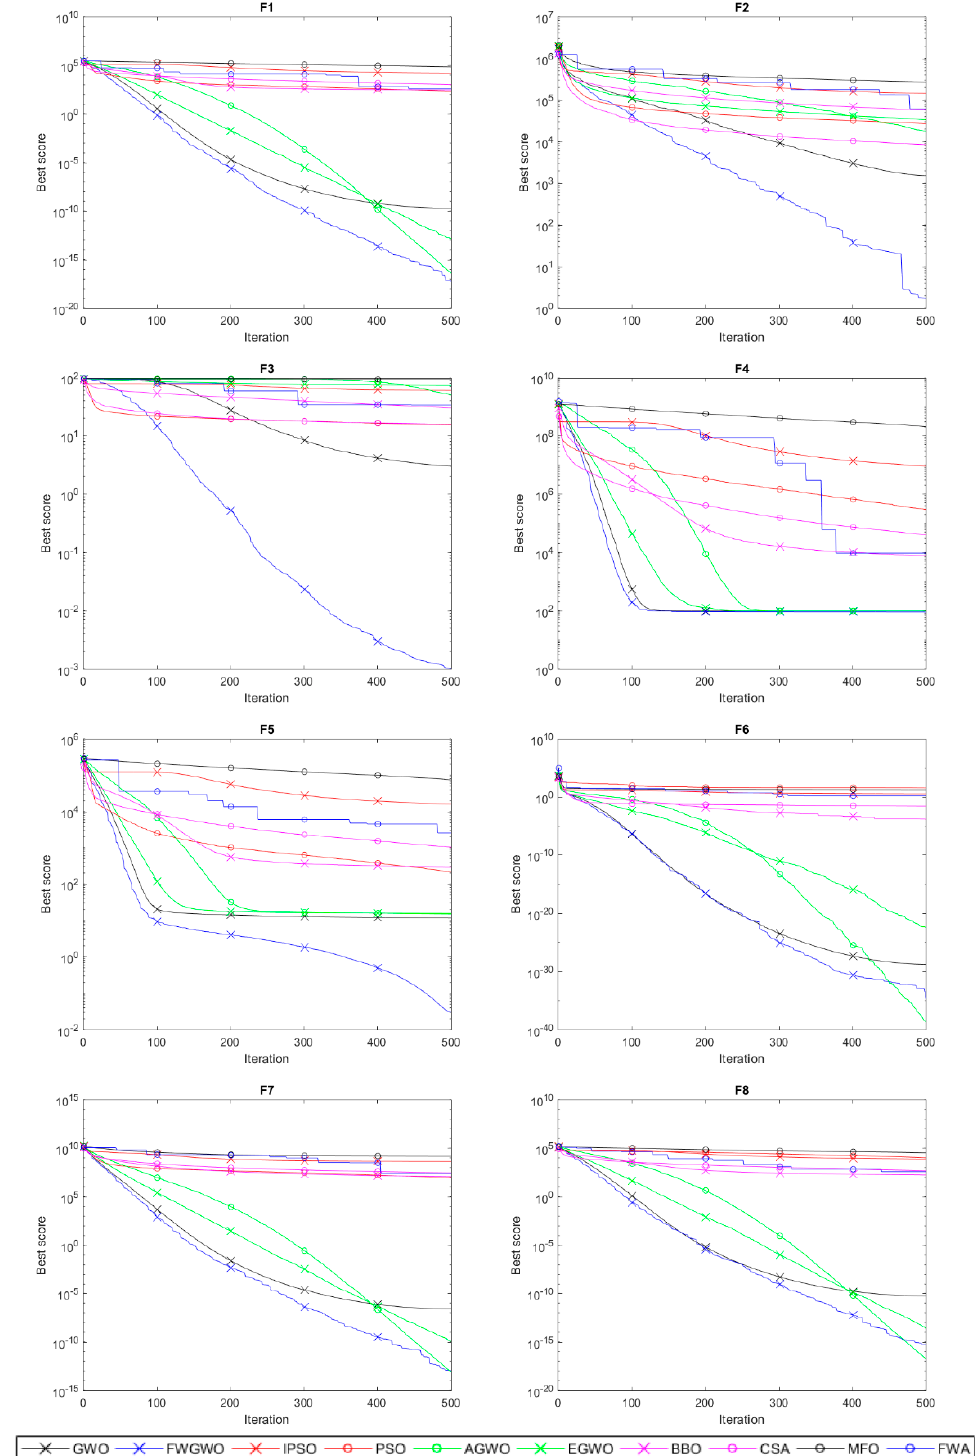
Figure 3. Convergence curves of the unimodal